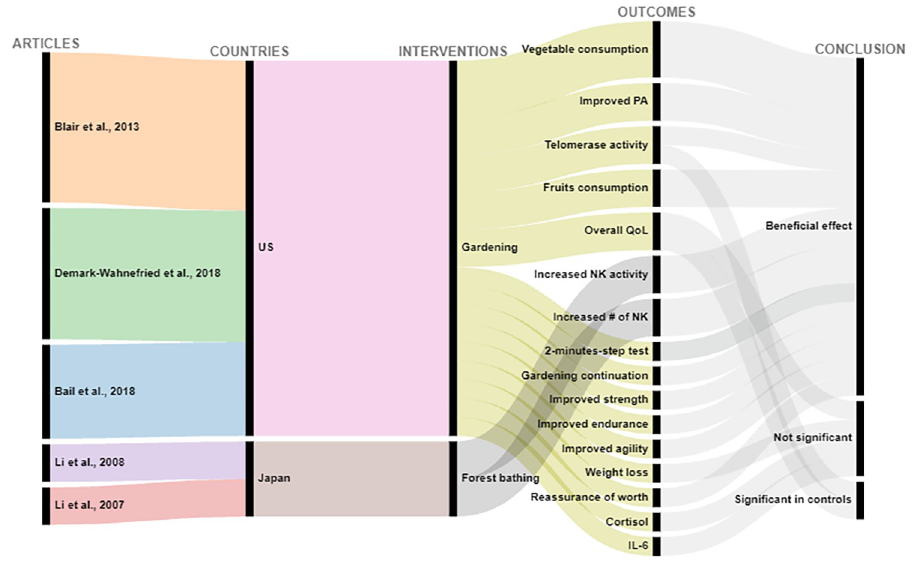
Fig 3. The impact of greenspace or nature based interventions on cancer-related outcomes. The first column represents articles, the second column represents geographical settings of studies, the third column represents specific interventions used in the studies, the fourth column represents the measures of cancer-related outcomes, while the fifth column represents the conclusion in terms of protective effects (beneficial effect), no significant results (not significant) or control groups had better outcomes than experimental groups (significant in controls).This graphical representation shows an overall trend in findings across studies. Acronyms : PA 1 : Physical activity; NK 2 : Natural killer cells; QoL 3 : Quality of life; and IL-6 4 :